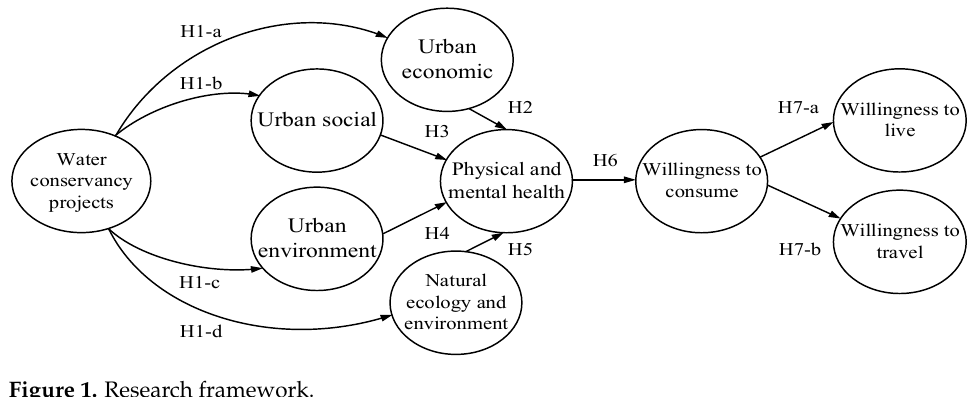
Figure 1. Research